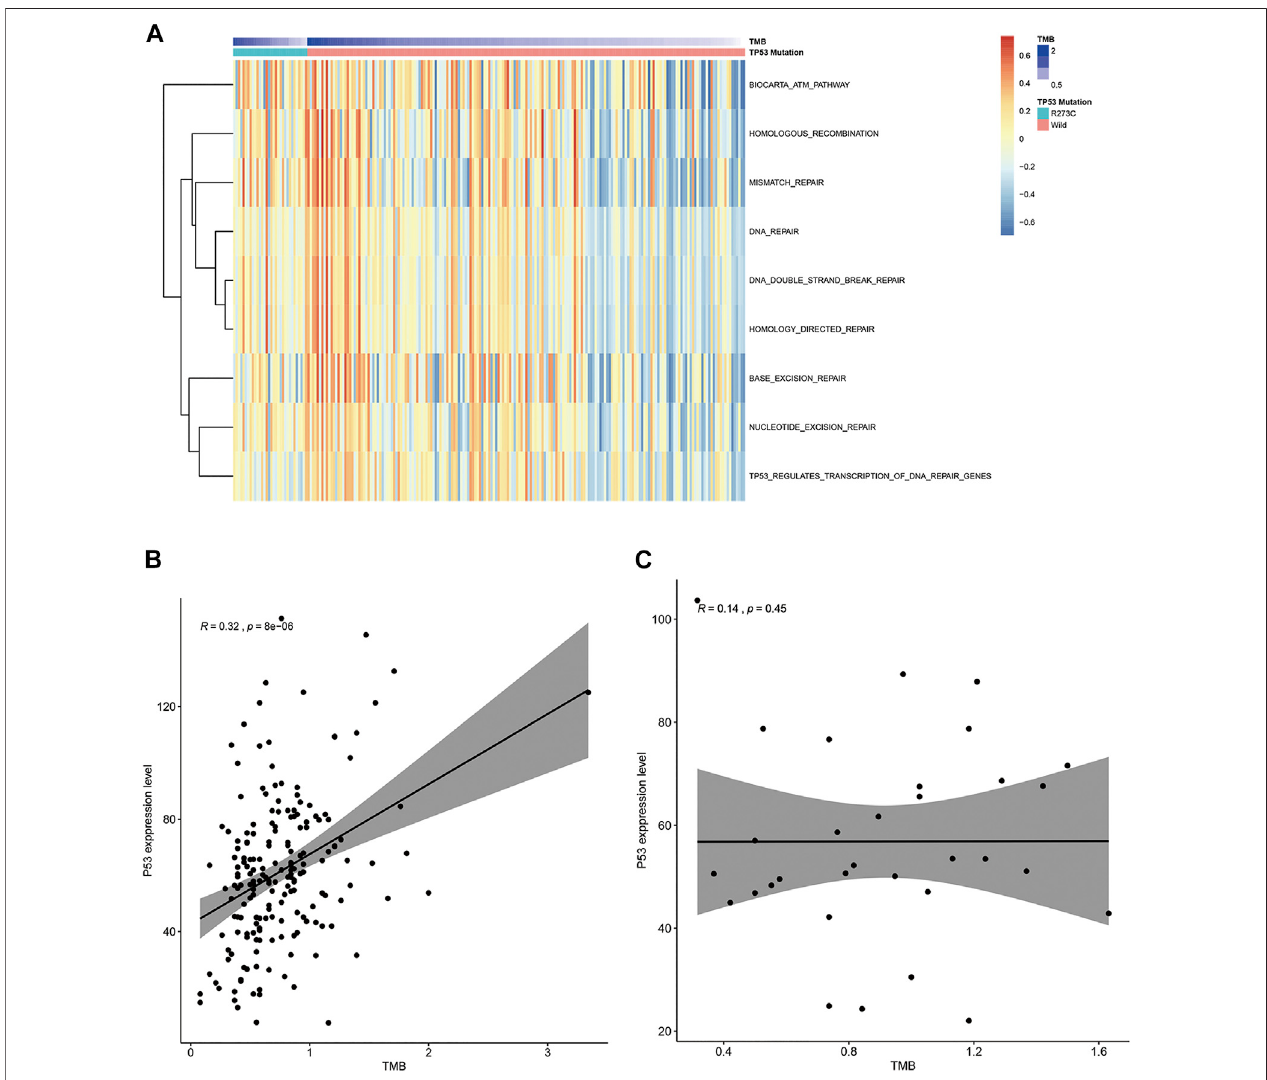
FIGURE 5 | TMB and DNA damage/repair. (A) The association between TMB and DNA damage/repair pathways. (B, C) The relationship between TMB and the TP53 expression level in patients with wild-type TP53 (B) and the TP53 R273C mutant (C) ; R, Spearman coef fi cient.